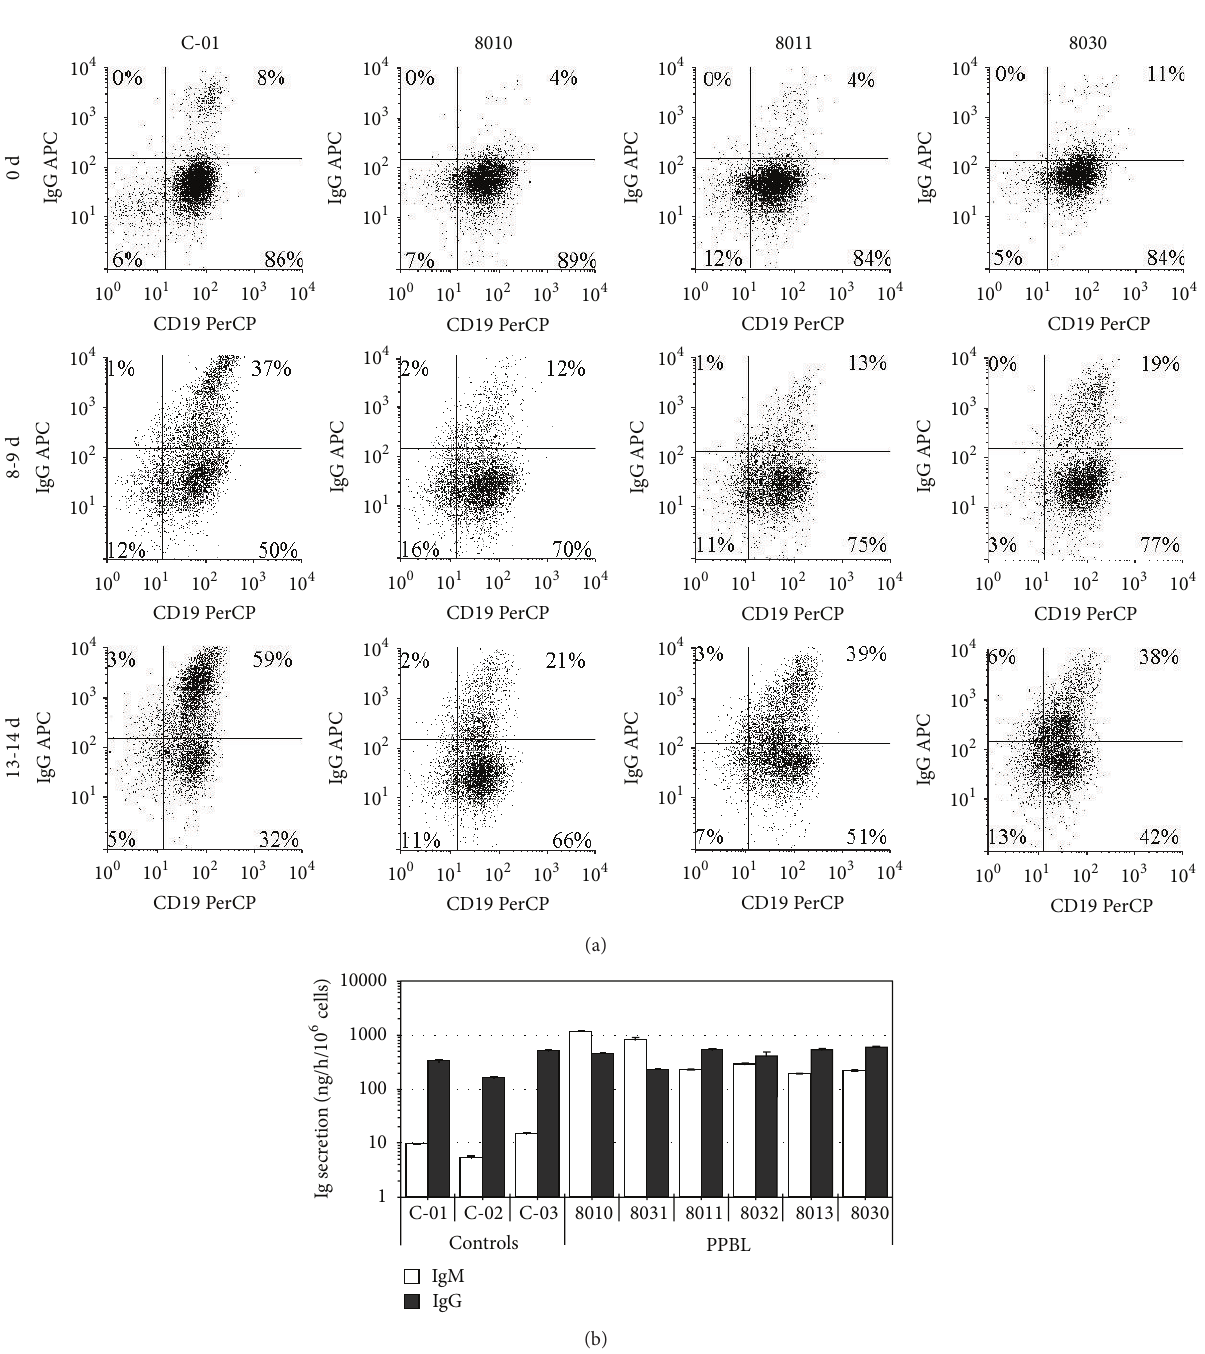
Figure 4: PPBL B cells can morph into IgG secreting cells following long-term CD154 stimulation. B cells stimulated with a low level of CD154 interaction (Figure 2) were analyzed for their ability to express and secrete IgG. (a) The proportion of IgG + within CD19 + cells before (0d) and after exposure to a low level of CD154 interaction (8d and 13 d for 8030 and 9 d and 14d for 8010 and 8011) was determined by flow cytometry. These phenotypes are representative of the six analyzed samples. (b) IgG and IgM secretion rates were determined at the end of the culture periods on all samples (patients and healthy